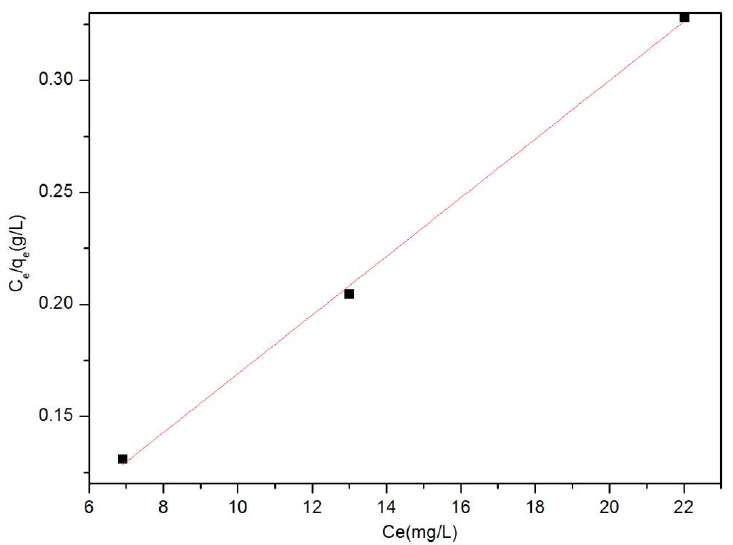
Figure 9. Langmuir isotherm for the adsorption of CR on Fe-MOFs (50 mg, 50 ppm, 20 ° C). Table 3. Summary of Langmuir and Freundlich isotherm constants for the removal of RhB by Fe-MOFs.